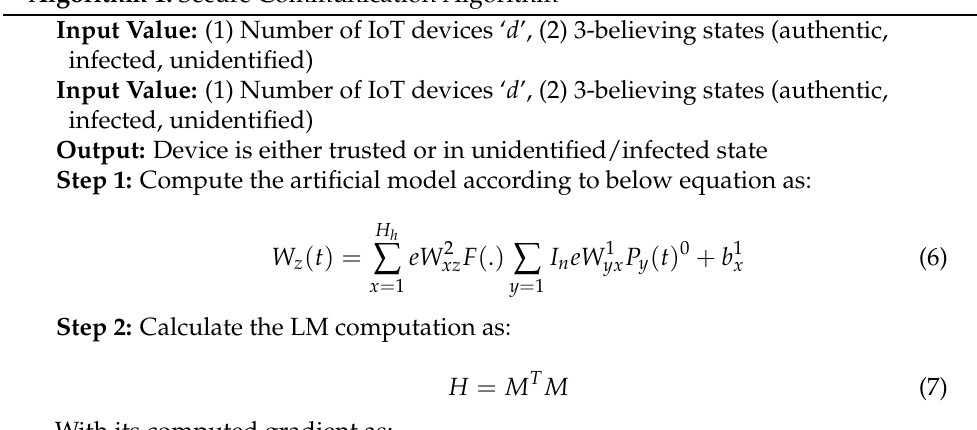
Algorithm 1: Secure Communication